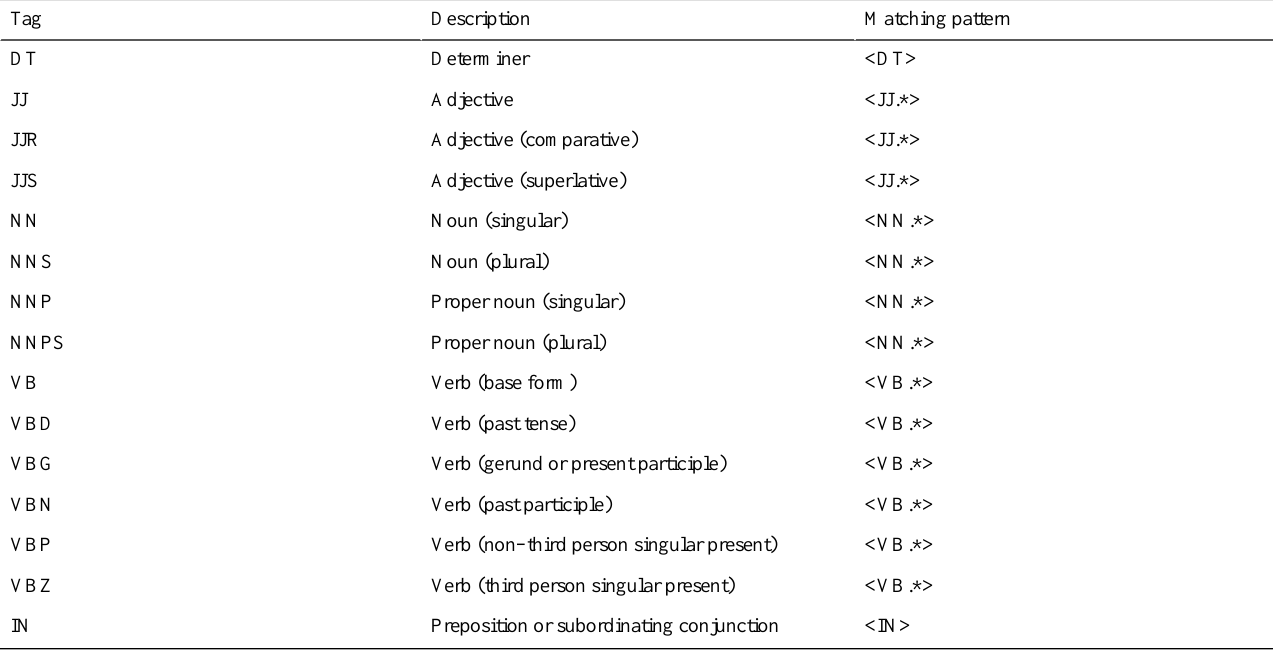
Table 1. Part-of-speech tags, description, and the corresponding matching part-of-speech